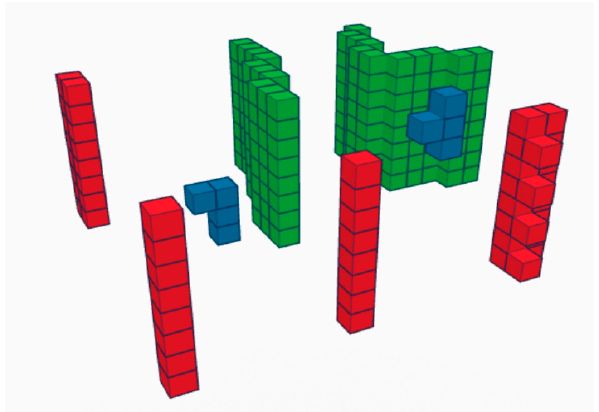
Figure 3. Three-dimensional assembling and analysis. Green groups: voxels in sections that do not fulfill the isolation requirements; Blue groups: voxel groups with valid sections, but without vertical continuity or enough height; Red groups: poles.